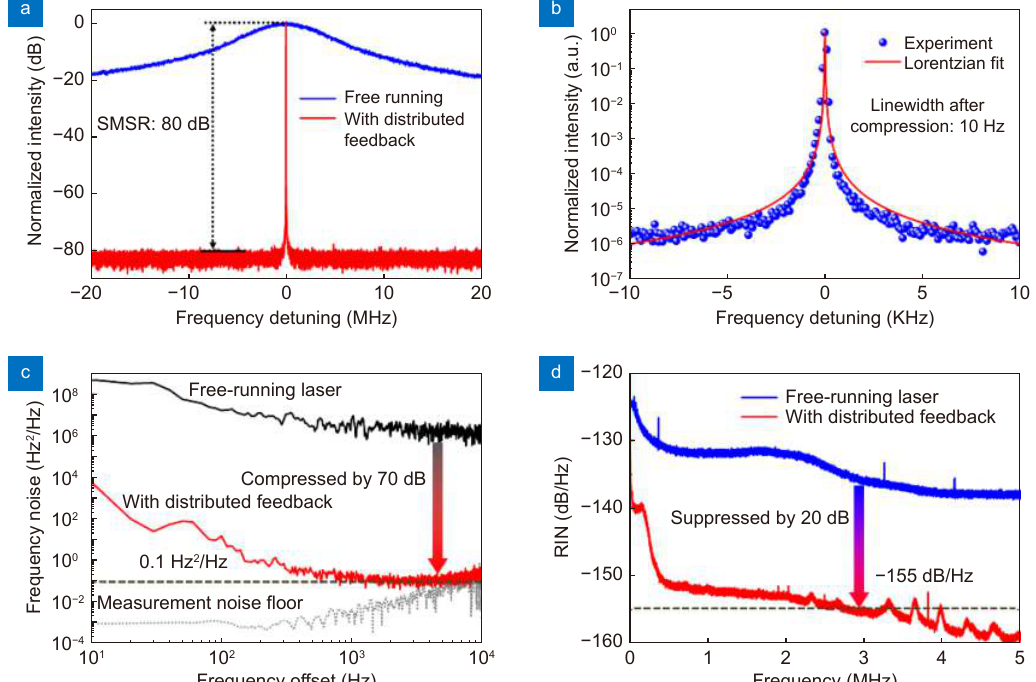
Fig. 4 | Power spectra of the RF signal generated by beating two distributed feedback DFB lasers and spectral purity. ( a ) Comparison curves of the frequency spectrum from beat frequency signal. ( b ) Lorentz fitting curve of the linewidth with a distributed feedback. ( c ) Comparis- on curves of the frequency noise PSD. ( d ) Comparison curves of the RIN spectrum, where a red curve indicates the compressed